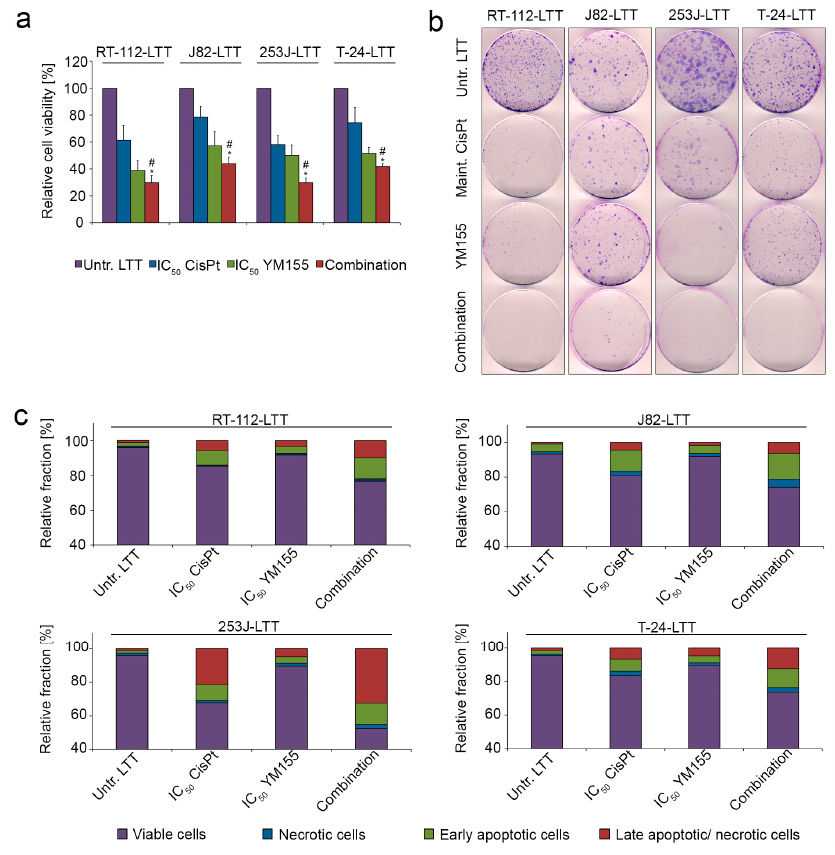
Figure 5. Cont. Figure 5.